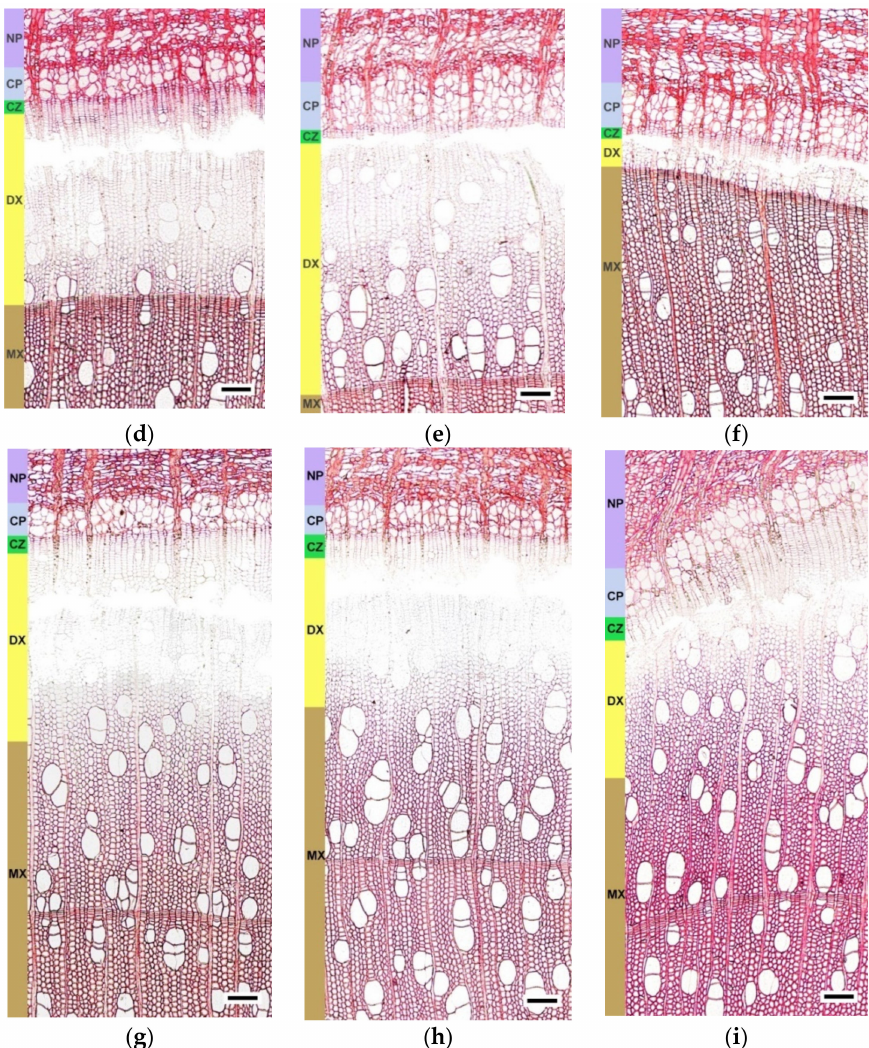
Figure 1. The transverse sections showing the stem tissues of B. pendula var. pendula ( a , d , g ), non- figured ( b , e , h ), and figured ( c , f , i ) B. pendula var. carelica trees. Samples were collected on 28 May